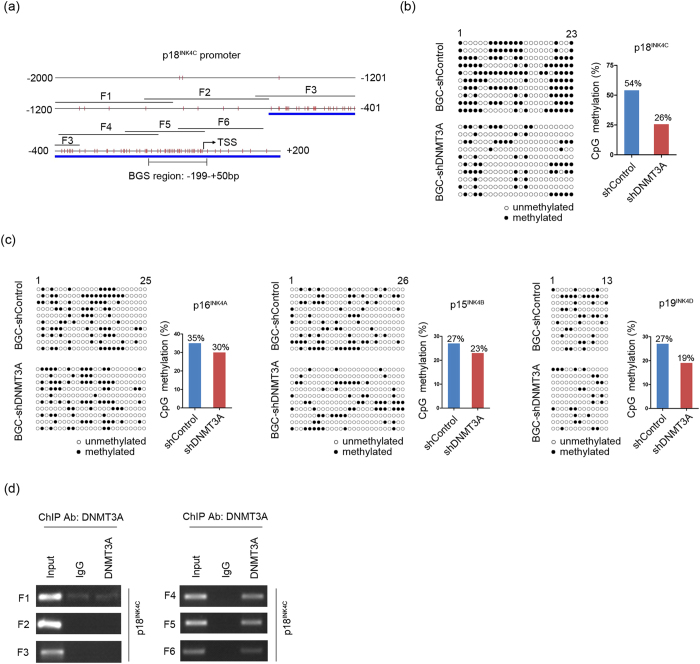
DNMT3A suppresses p18INK4C in a DNA methylation-dependent manner.(a) Diagram of the promoter of the p18INK4C gene, with the transcription start site (TSS) indicated. The blue line indicates the CpG island, and the red vertical line depicts a CpG site. One region (−199 bp ~ +50 bp) spanning a CpG island with 23 CpG sites was analyzed. The black line represents the location of the F1~F6 fragment detected by ChIP assay. (b,c) Methylation statuses of the INK4 member promoters in BGC-shControl and BGC-shDNMT3A cells, as detected by BGS assay (left panels). ○ represents unmethylated CpG sites; and ● represents methylated CpG sites. Each row represents a single sequence. The bar graphs depict the INK4 member promoter methylation rates (right panels). (d) ChIP assay was performed using a DNMT3A-specific antibody, followed by PCR amplification of six individual fragments representing p18INK4C promoter regions (F1–F6). Chromatin (defined as Input) and products immunoprecipitated by IgG were used as positive and negative controls, respectively.